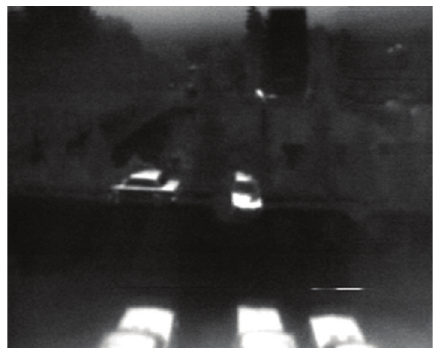
Figure 8: KUT26 WSS starting image.